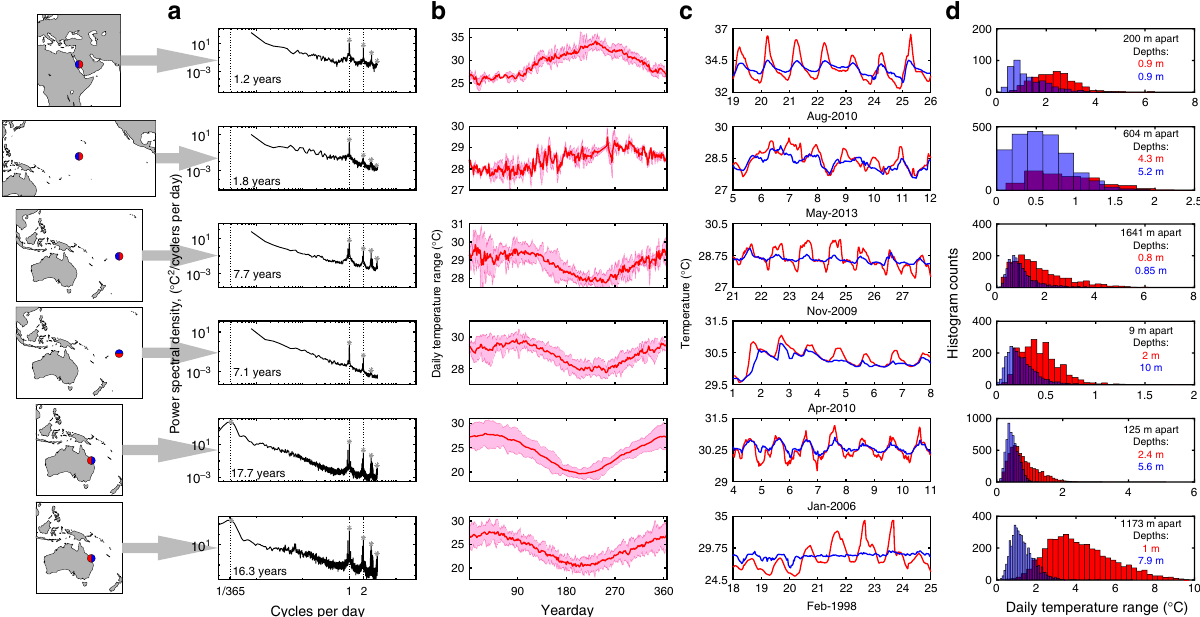
Fig. 2 Temperature variability of six reef records. a Power spectra of temperature for TA3, P21, OF3, VT1, HW1, and HR1, with asterisks marking signi fi cant peaks, b yearly composites of mean daily temperatures and temperature ranges (red and pink shading respectively) for the same six time series in a , c 7-day trends in temperatures at two different habitats on the reef, and d histograms of daily temperature range at the same two habitats on each reef. In each case, reef locations are shown in maps on the left (for site information see Supplementary Data 1), the full duration of temperature records are indicated in a , and the great-circle distances between same-reef sites are indicated in d . The maps were created using the MATLAB package “ M_Map ”